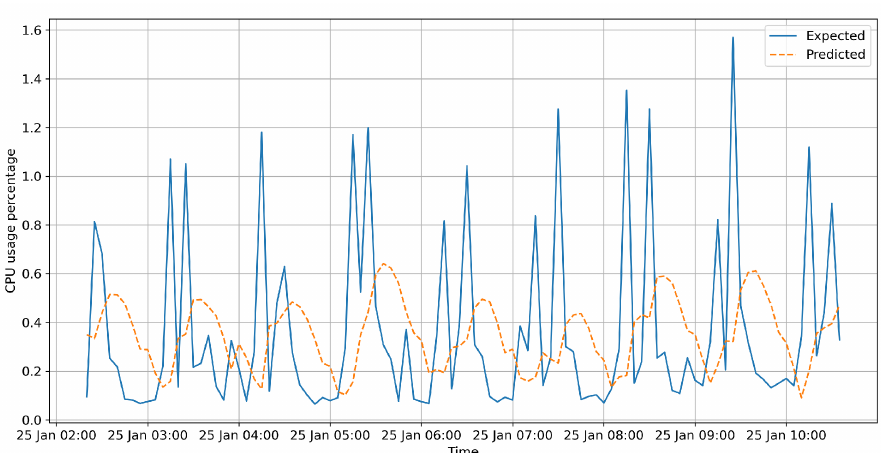
Figure 11. Sample validation predictions—LSTM.